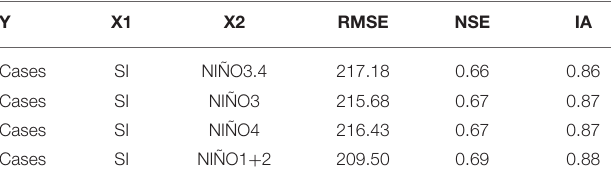
TABLE 2 | Results of performance indicators.